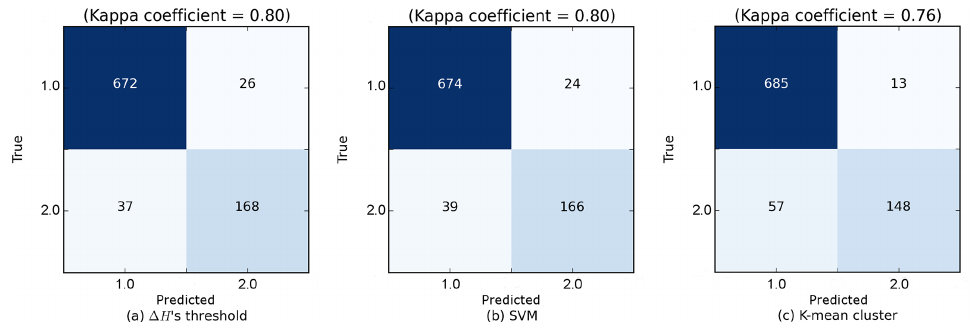
Figure 13. Confusion matrix calculated from the comparison of the ground truth data and the predicted damage levels based on the (cid:49)H threshold (a) , SVM (b) , and k -means clustering (c) . Two damage levels, noncollapsed (1.0) and collapsed (2.0), were